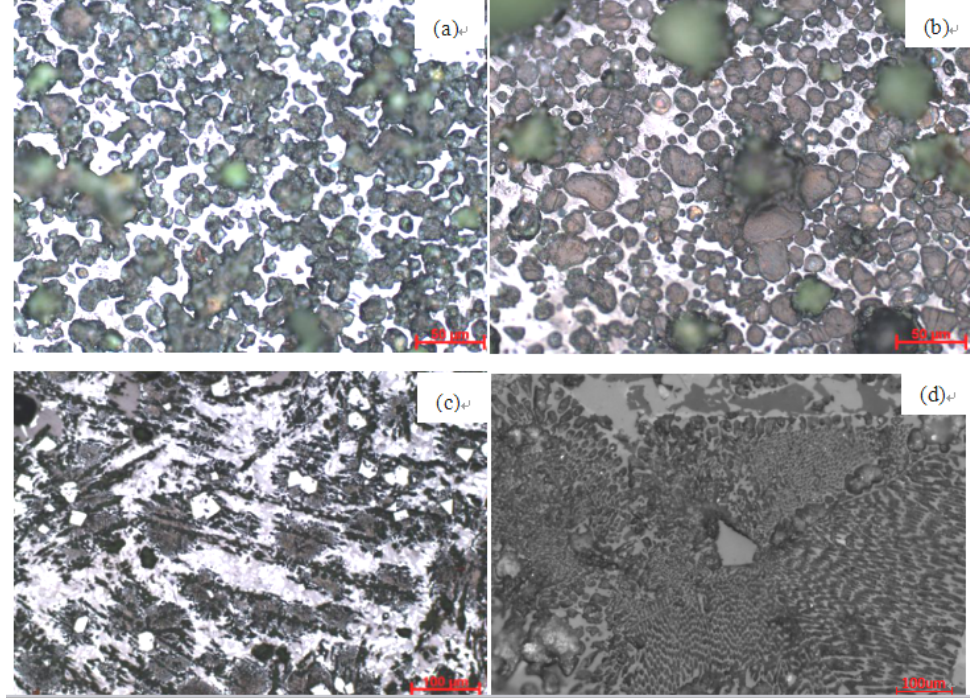
Figure 10: Lithofacies test images of reconstructed steel slag with different of CaF 2 contents. (a) 0, (b) 1, (c) 3, and (d) 5 wt% CaF 2 .